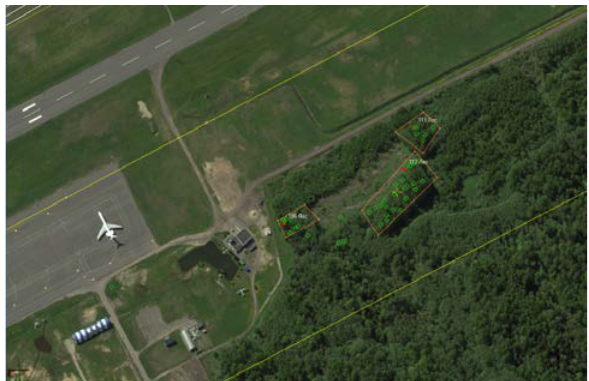
Figure 3. The example in which wood penetrates a transitional surface